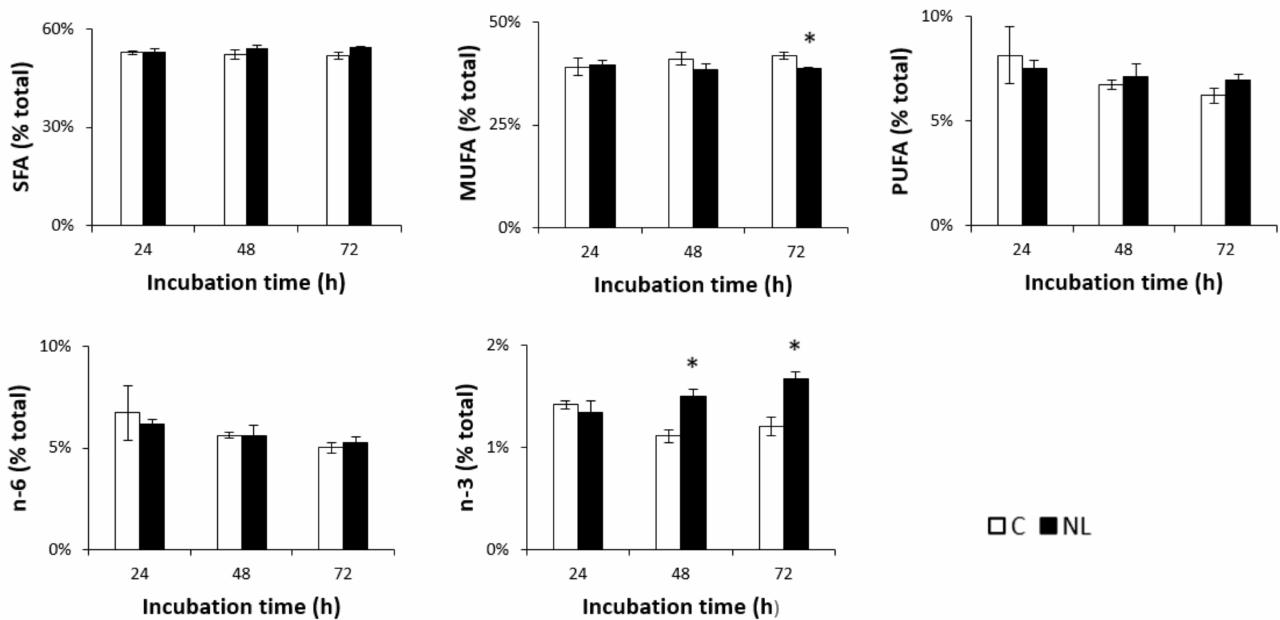
Figure 2. SFA, MUFA, PUFA, n-3, and n-6 profiles (% total) in primary cultures of rat embryo cortical neurons treated with NLs and in the control group depending on incubation time. Cells were incubated at 37 ◦ C in the absence (C) or presence (NL) of 10 µ g/mL NLs. Fatty acid composition was analyzed via gas chromatography after 24 h, 48 h, and 72 h of incubation. The values are expressed as the mean ± SD of % total fatty acids. SFAs: saturated fatty acids; MUFAs: monounsaturated fatty acids; PUFAs: polyunsaturated fatty acids; n-6: n-6 fatty acids; n-3: n-3 fatty acids. Statistical differences between groups for each fatty acid are shown within each timepoint (* p <